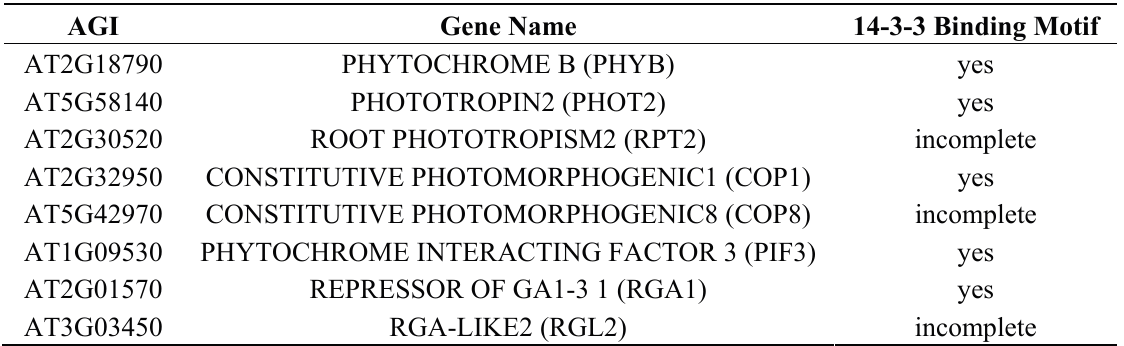
Table 1. List of light-related 14-3-3 candidate partners recovered from the affinity purification strategy [7]. The Arabidopsis Genome Identification (AGI) and presence of the 14-3-3 binding motif in each protein are also